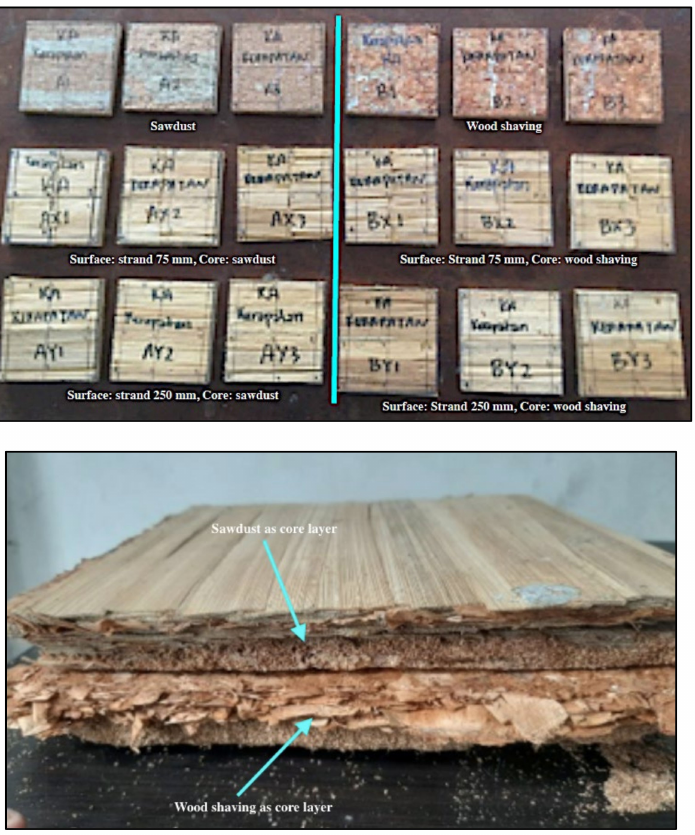
Figure 6. The appearance of coated and uncoated particleboard with belangke bamboo